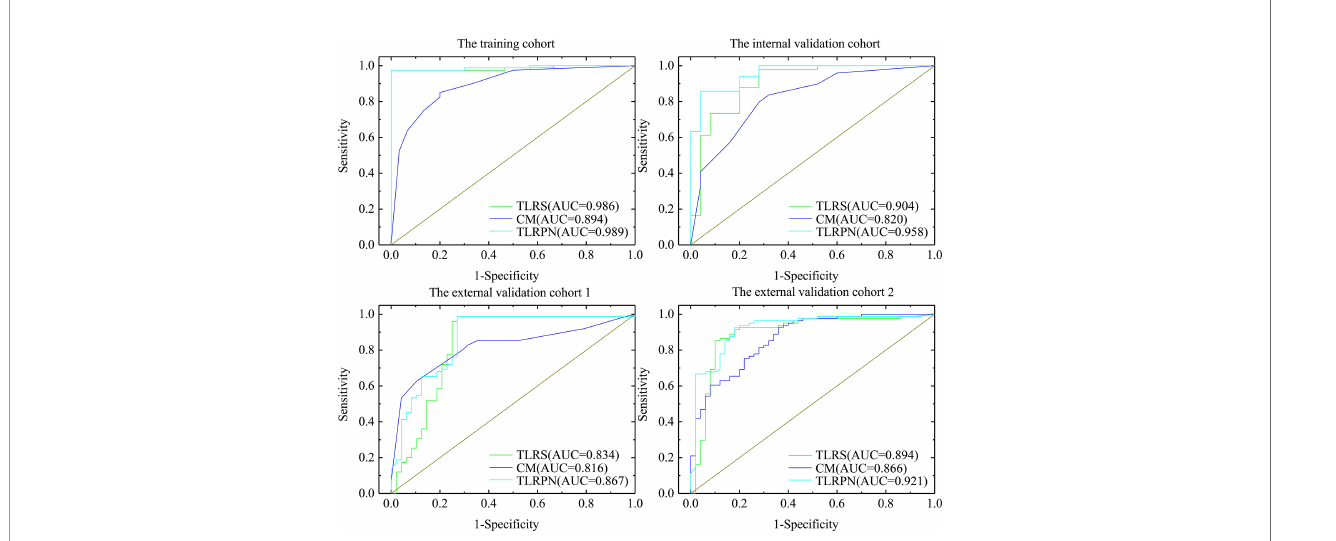
FIGURE 3 | The AUCs of three model. The clinical model, transfer learning radiomics signature based on the pathological image of gastric cancer (TLRS) and transfer learning radiomics nomogram